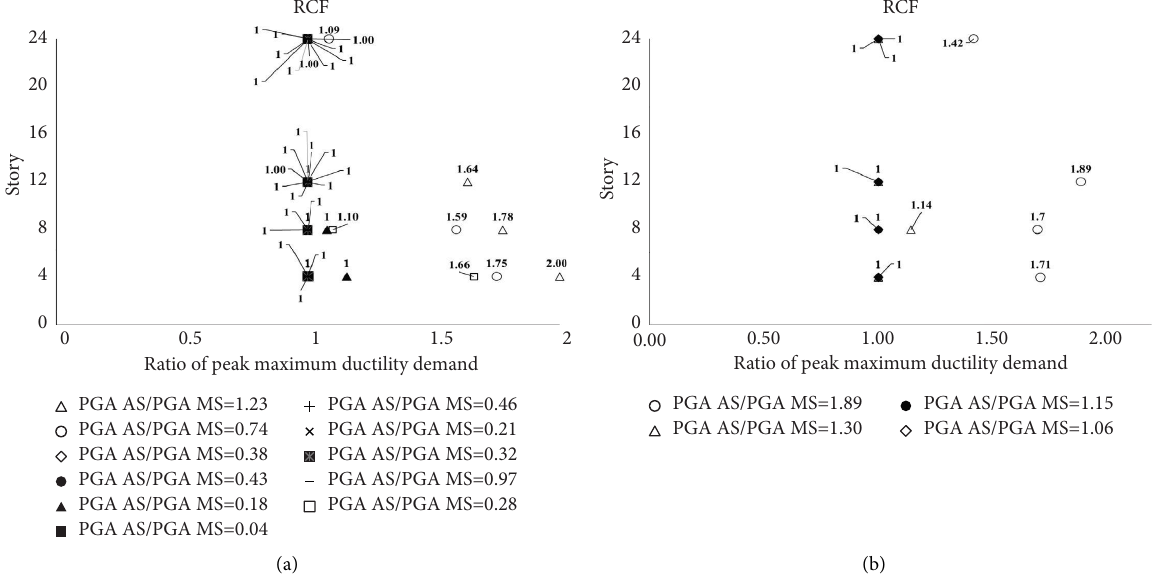
Figure 17: Ratio of peak maximum ductility demand of RCF in SS to MS: (a) combination of group I and II, (b) group III.